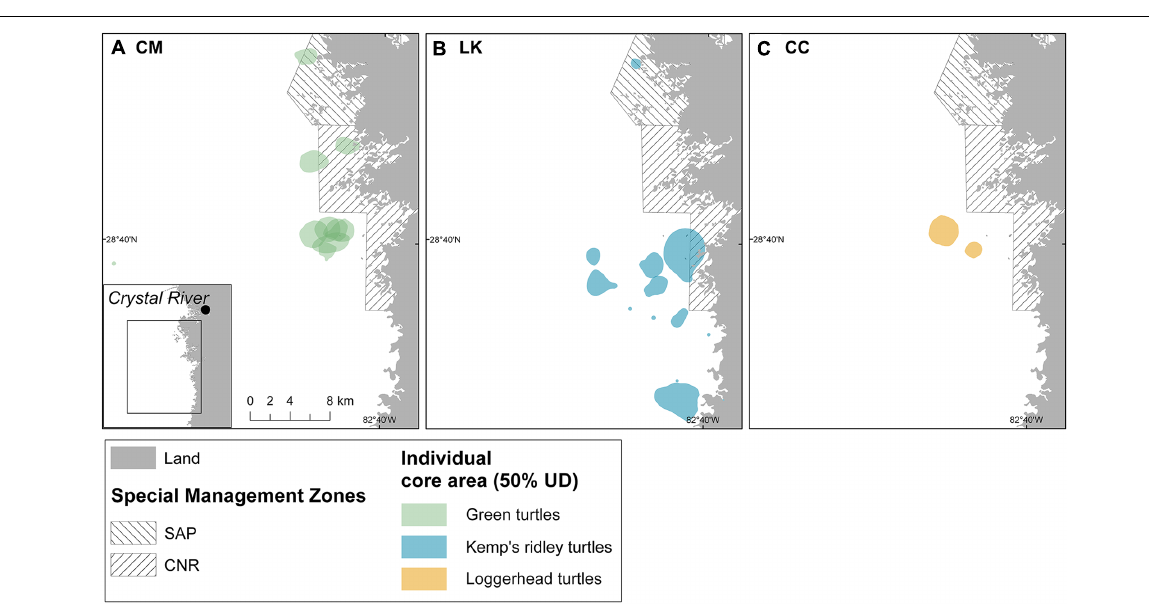
FIGURE 4 | Spatial distribution of core areas (50% UD) of turtles tracked between July and September (2014–2017) in the Crystal River region, United States: (A) 9 CM green turtles; (B) 5 LK Kemp’s ridley turtles; and (C) 2 CC loggerhead turtles. SAP, St. Martins Marsh Aquatic Preserve; CNR, Chassahowitzka National Wildlife